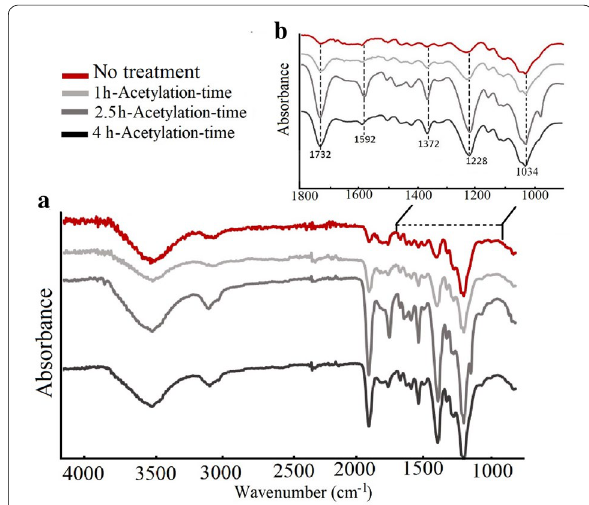
Fig. 1 FTIR spectra of V. ferruginea wood treated with acetic anhydride at three different acetylation times